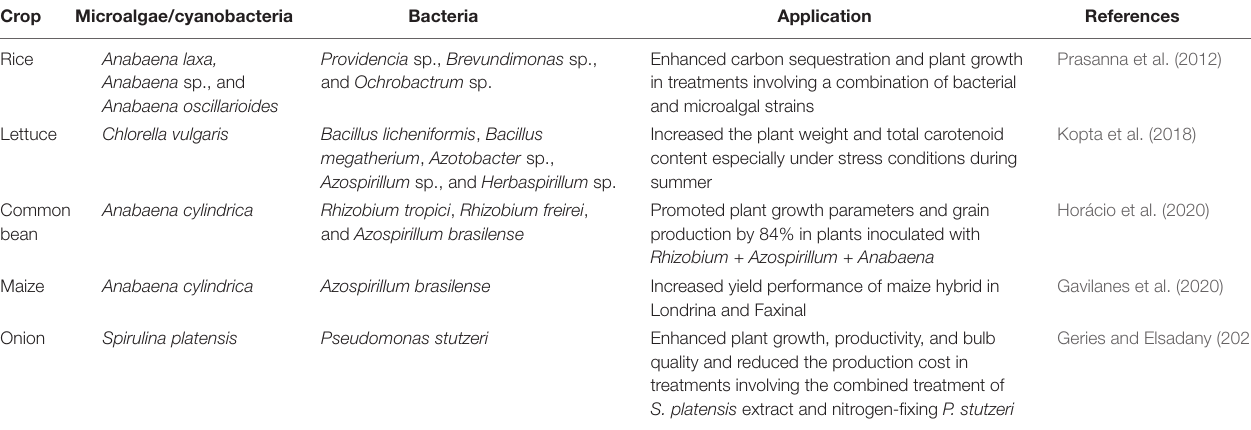
TABLE 4 | Examples of co-inoculation of microalgae–bacteria in